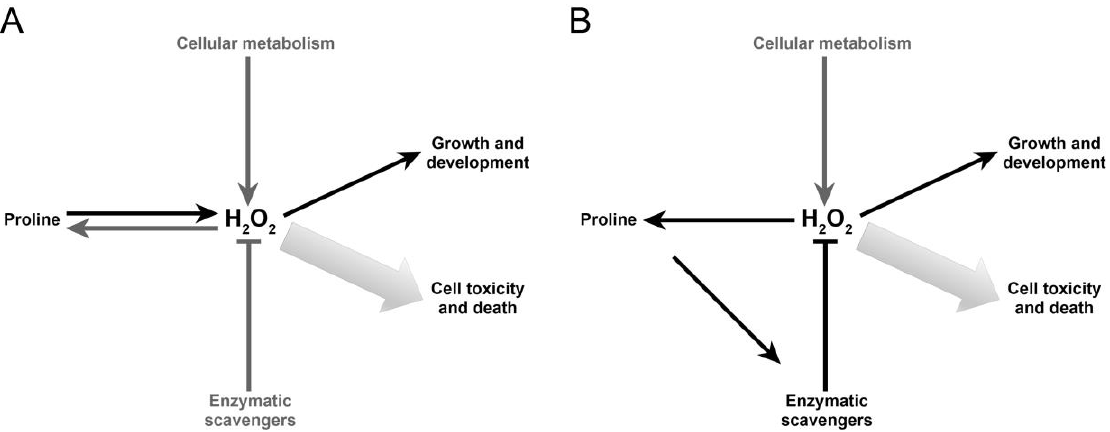
Figure 11. Possible models of interactions between proline and ROS. Proline catabolism stimulates the accumulation of H 2 O 2 production, which, in turn, can induce proline synthesis ( A ). Proline seems not able to scavenge directly H 2 O 2 but might indirectly control its accumulation by enhancing the activities of key antioxidant enzymes ( B ).